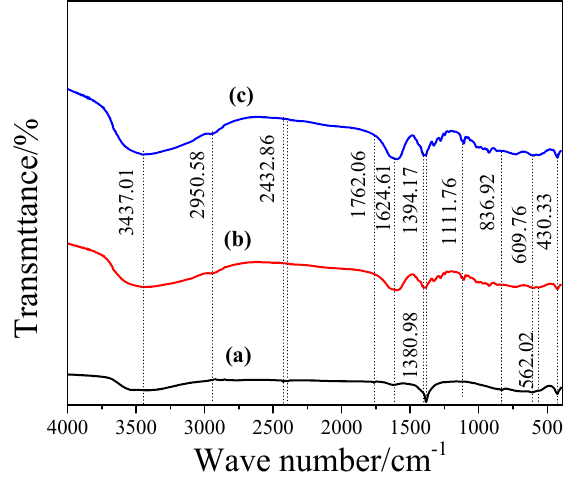
Figure 5. FT-IR spectra of ( a ) L1, ( b ) L2, ( c ) L2-Eu.